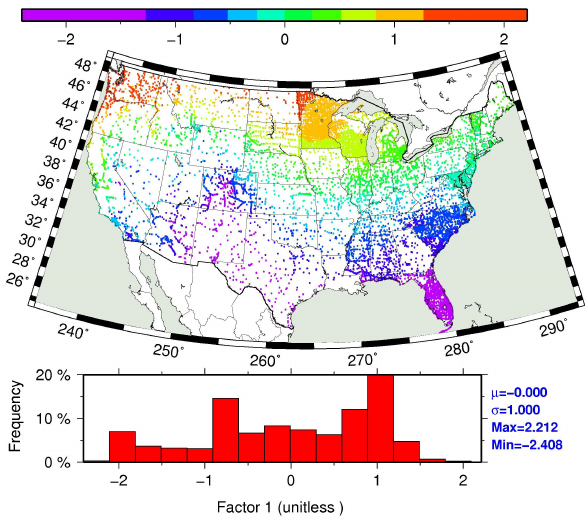
Figure 7: The first factor scores of the FA results.